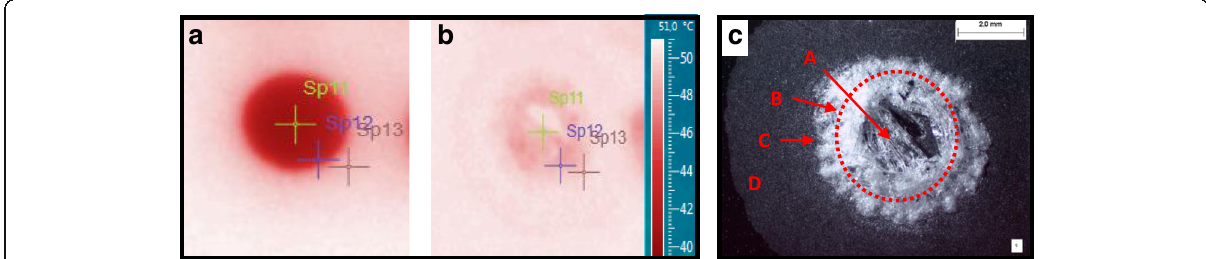
Fig. 2 Droplets observed by IRT and binocular microscope. ( a ) Infrared image of a droplet at the beginning of the test. ( b ) Infrared image of the same droplet after complete evaporation. ( c ) Visual image of the evaporated droplet with the four studied